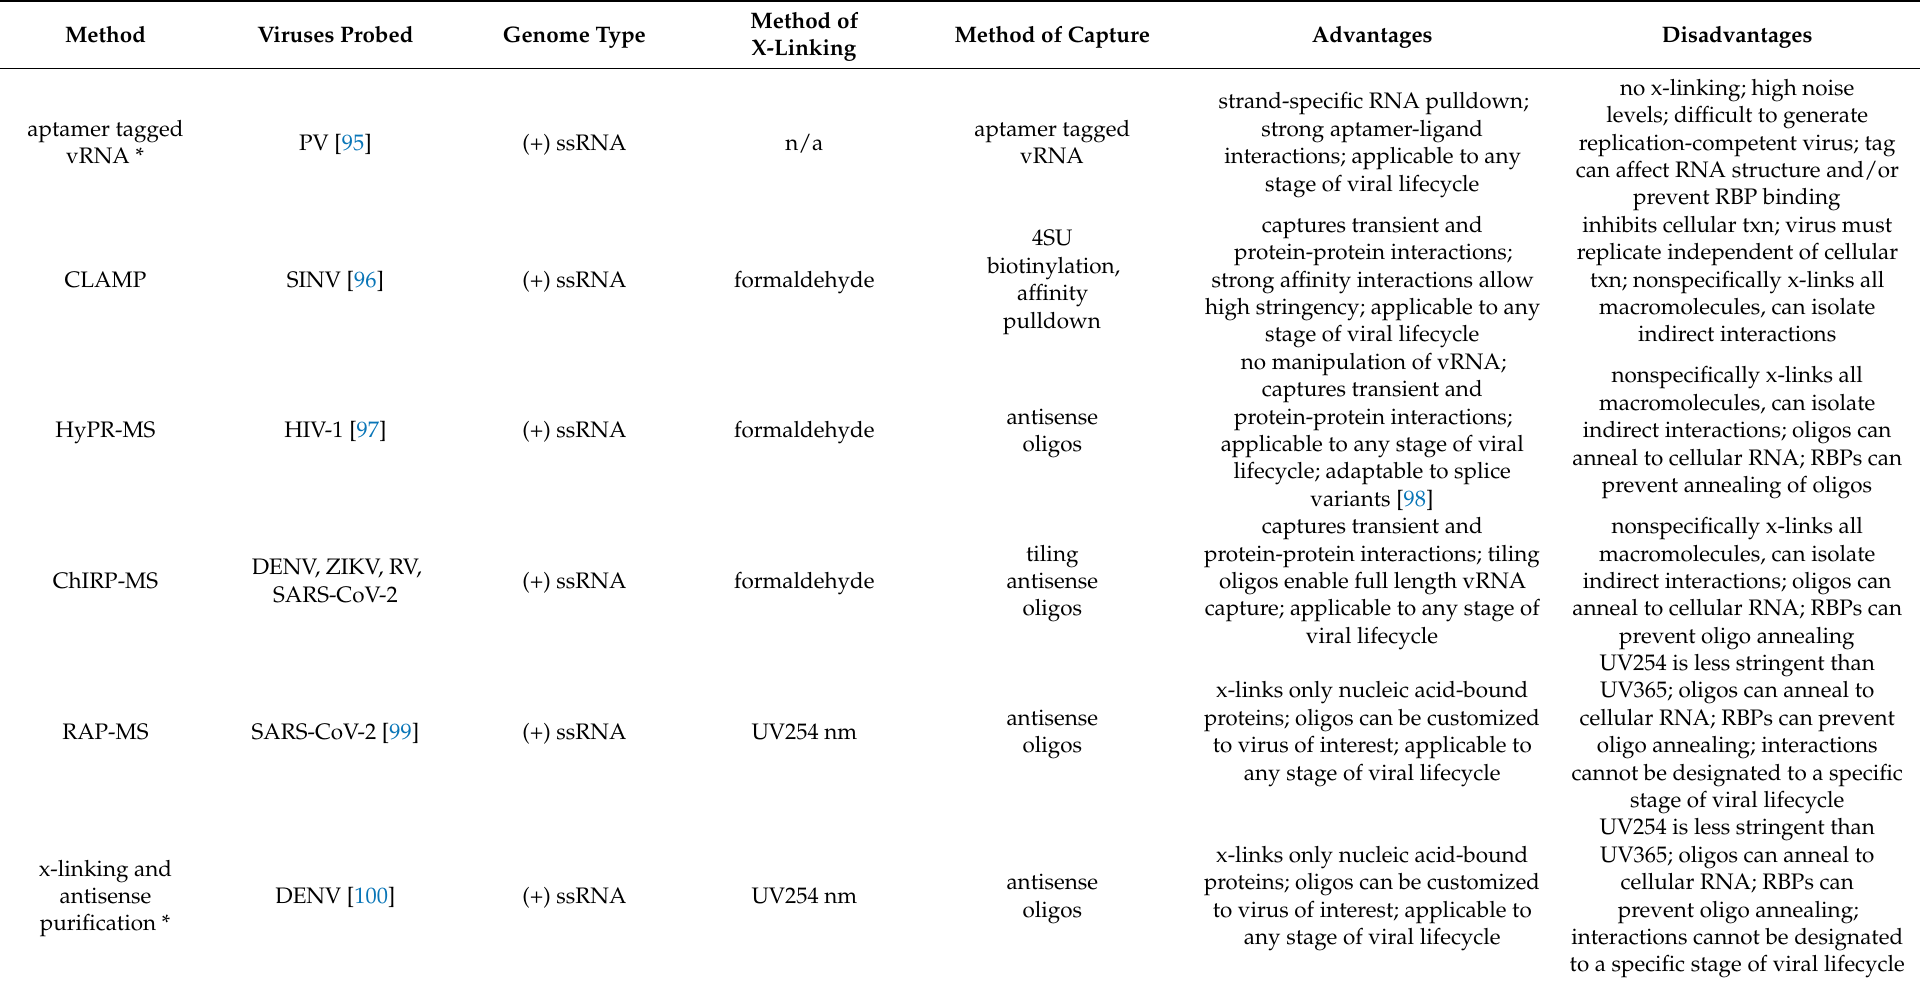
Table 1. RNA-centric approaches to capture vRNA-RBP interactions from live cells have overlapping yet distinct methodologies. Outlined are crosslinking agents, methods of capture, viruses probed, advantages, and disadvantages of each